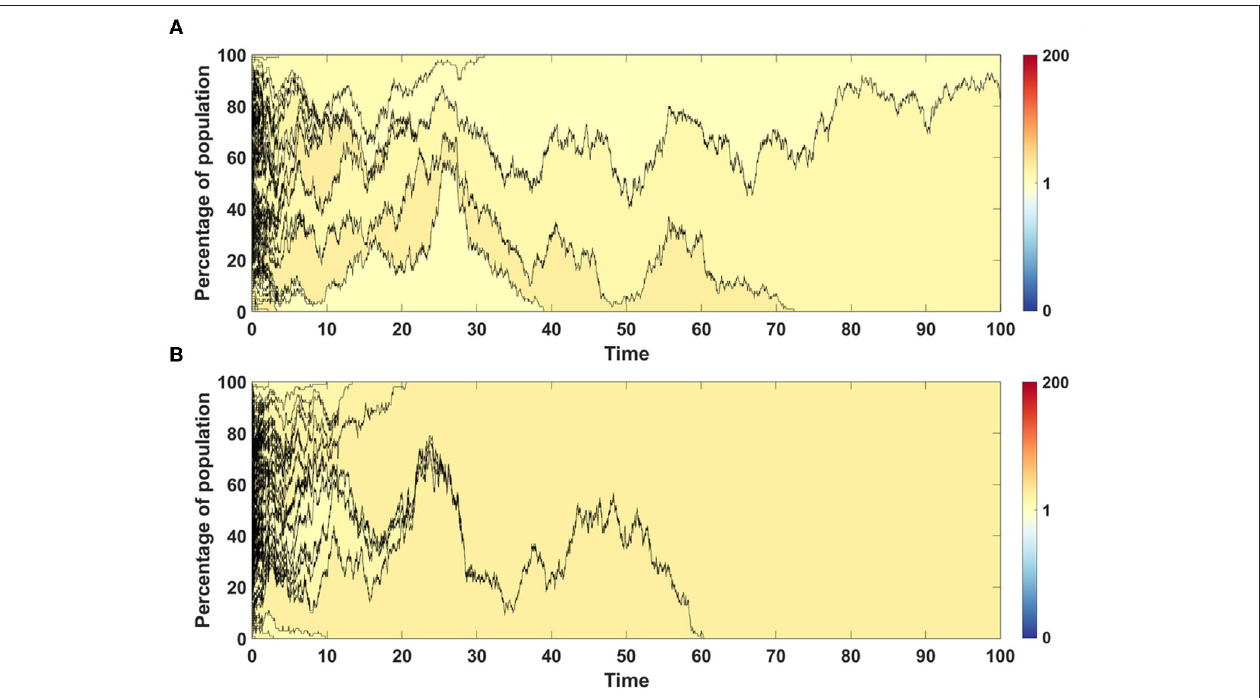
FIGURE 7 | Time succession patterns of clones colored according to their fitness. Results of one simulation on N = 100 cells with no mutation process, but with initial number of drivers and passengers drawn from exponential distribution with parameter 10 × p for number of drivers and 10 × (1 − p ) for passengers, with p = 0.5. (A) Model A; (B) Model